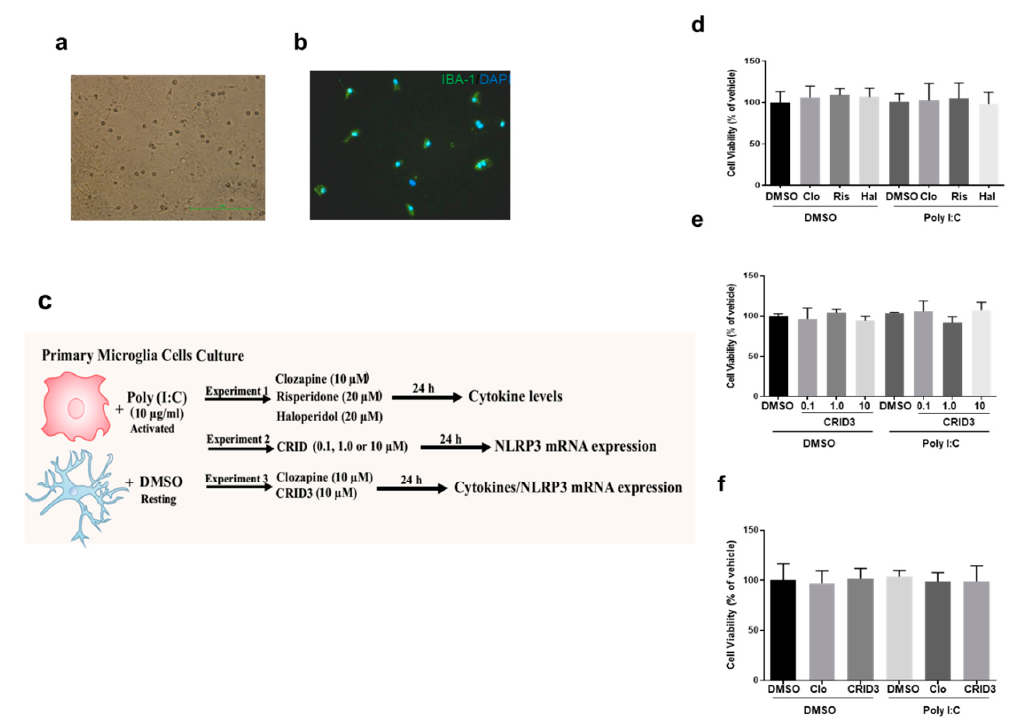
Figure 1. Mixed culture of glial cells from postnatal rat brains showing microglial cells as small round cells on top of the astrocytic monolayer, scale bar = 1 mm ( a ). Cell-type characterization of primary microglial cell cultures. Microglial cells identified using anti-Iba-1 primary and fluorescein isothiocyanate (FITC)-conjugated secondary antibodies ( b ). The schematic representation of the experimental design ( c ). 3-(4,5-dimethylthiazol-2-yl)-2,5-diphenyltetrazolium bromide (MTT) assay with antipsychotics (clozapine (CLO), risperidone (RIS), haloperidol (HAL)) ( d ). MTT assay with CRID3 (0.1, 1.0 or 10 μ M) ( e ). MTT assay with 10 μ M CLO and 10 μ M CRID3 ( f ). Following treatment